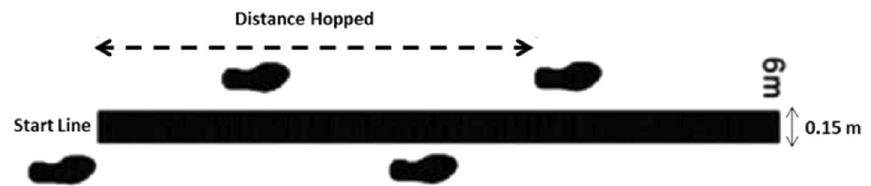
Figure 2. Set up for the cross-over hop test.